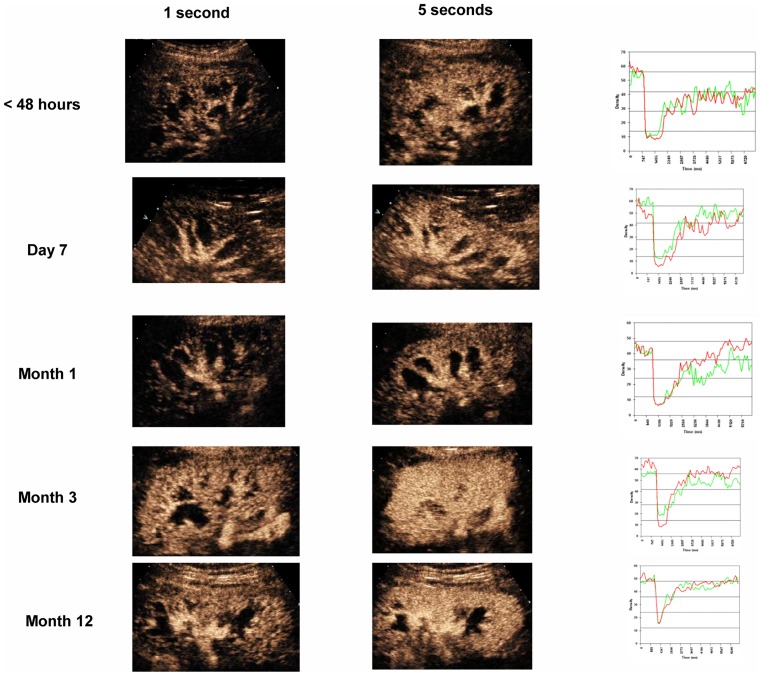
Actual example of the studies performed in a brain-death donor recipient over time.RT-CES images obtained at 1 (a) and 5 (b) seconds from refilling after bubble destruction at various times 1 year after transplantation. On the corresponding right side, flow-volume curves obtained at 2regions of interest (red and green) are shown (c). Initial image (1a and 1b) demonstrates obvious renal flow in the large vessels (a and b) and renal cortex (b). At days 7 and 30, these images are very similar, reflecting the same structures at each moment. However, images at month 3 show early cortical flow (4a) not present in prior examinations(1–3 a), demonstrating faster cortical refilling. Very similar features are found at month 12 (5). Images 1-5c show flow-volume curves that reflect the number of cortical capillaries in the refilling phase. There is a notable correspondence between the 2 measurements along all studies (red and green) and the differences in the area under the curve (AUC) between 1c and 2-5c.